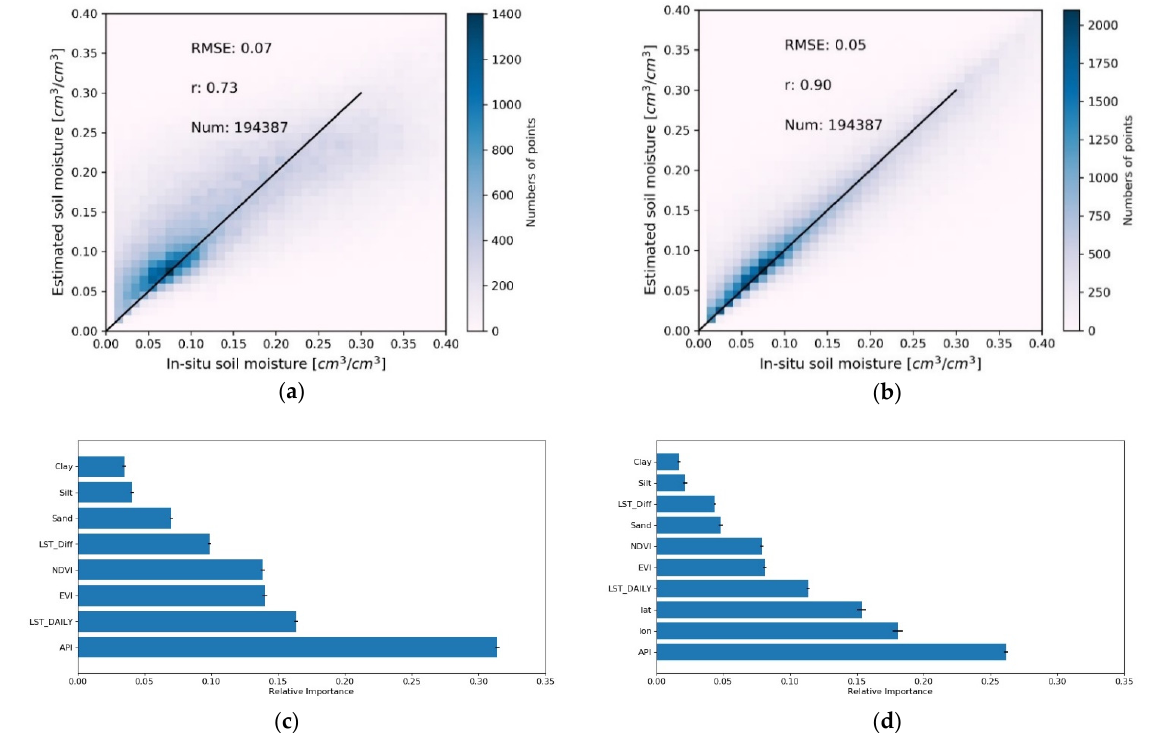
Figure 3. Model validation and feature importance. ( a , b ) shows the scatterplot of predicted and in situ soil moisture based on the test set (N = 194,387) for the RF model without and with geographic coordinates. ( c , d ) are the feature importance.